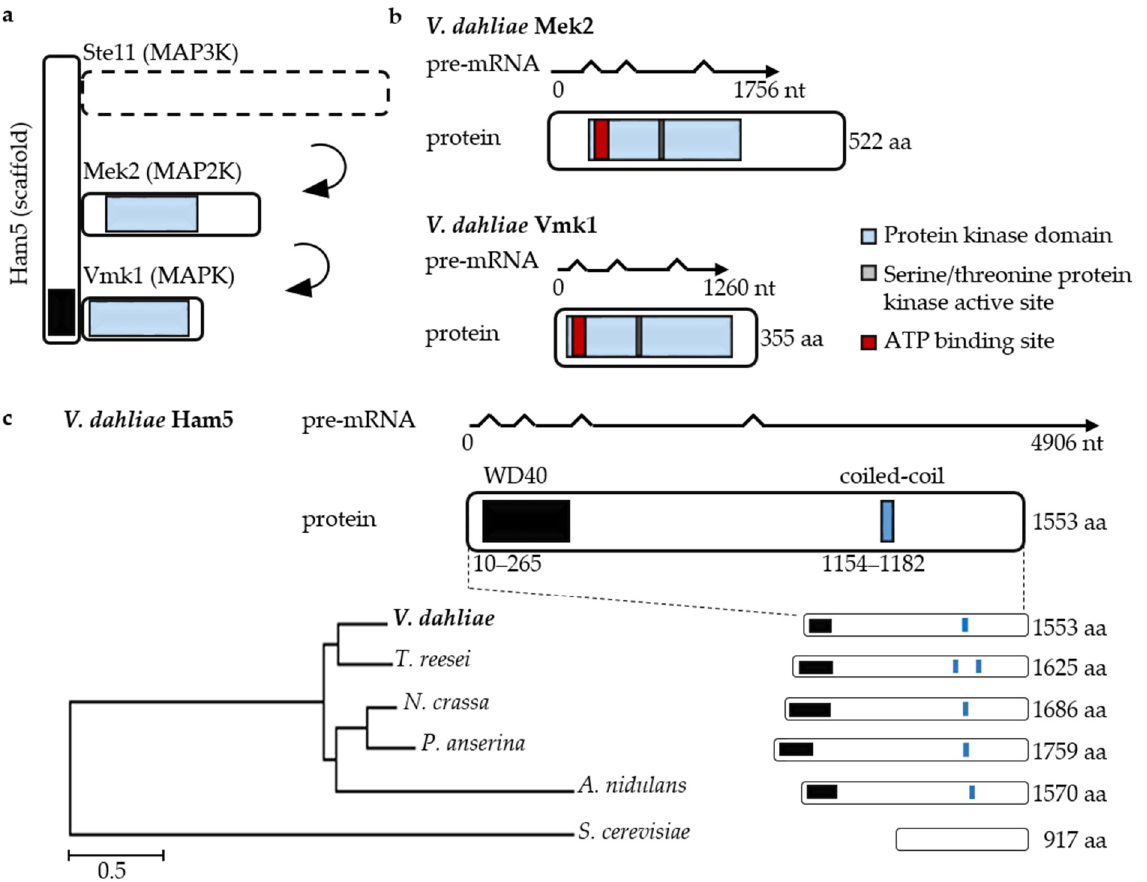
Figure 6. Pheromone response mitogen-activated protein (MAP) kinase module of Verticillium dahliae .